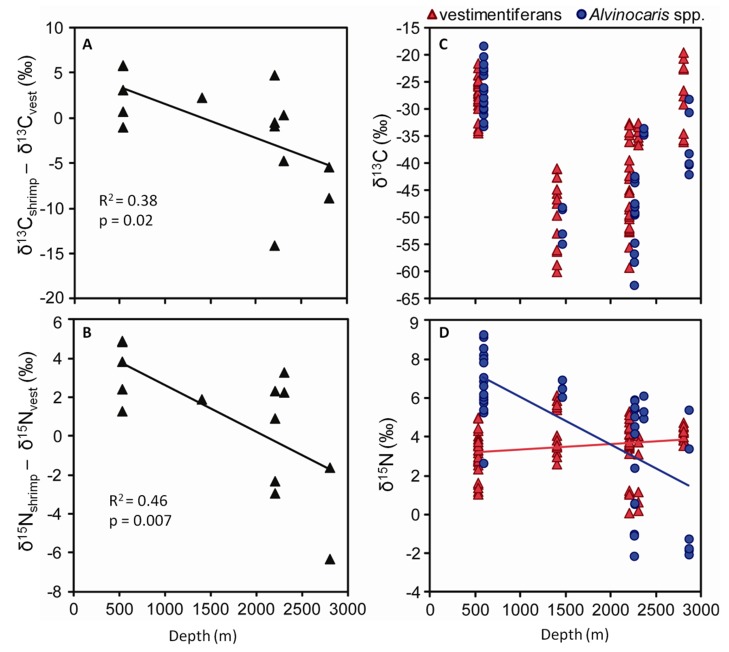
Patterns in tissue δ13C and δ15N values with depth in Alvinocaris shrimp and vestimentiferans.(A) The difference between the mean δ13C of Alvinocaris shrimp (δ13Cshrimp) in each collection and the mean δ13C of the vestimentiferan tubeworms in the same collections (δ13Cvest) vs. depth. (B) The difference between the mean δ15N of Alvinocaris shrimp (δ15Nshrimp) in each collection and the mean δ15N of the vestimentiferan tubeworms in the same collections (δ15Nvest). (C) δ13C and (D) δ15N values for each individual Alvinocaris shrimp and vestimentiferan tubeworm sampled vs. depth.